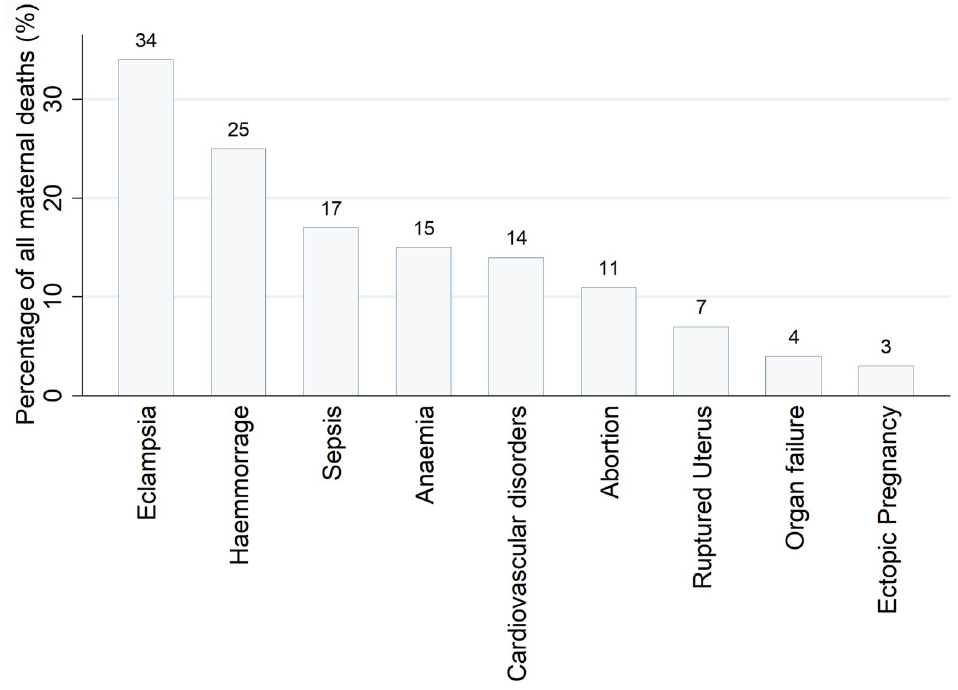
Fig 6. The proportion of major direct and indirect causes of maternal deaths, 2006–2015 (n = 1,987).